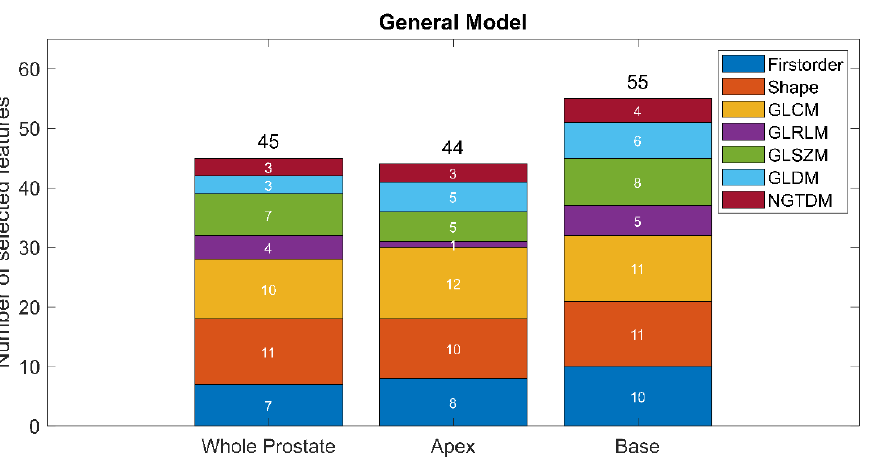
Figure 4. The distribution of the selected features in the optimized General model.